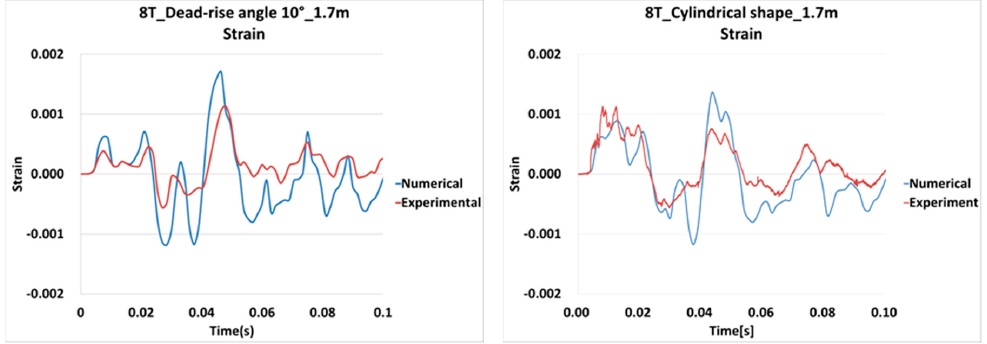
Figure 17. Comparison of strain values obtained from experimental results and numerical simulation.